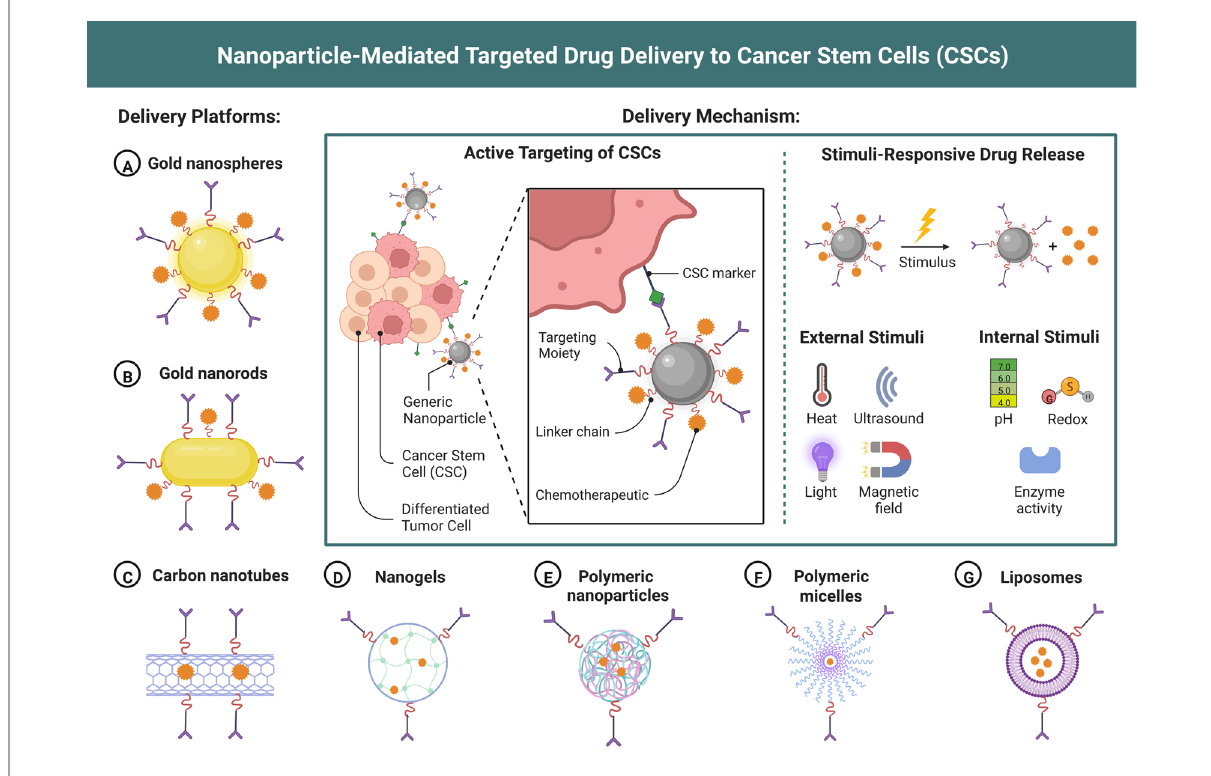
FIGURE 2 Nanoparticle-Mediated targeted drug delivery for cancer treatment. (Reprinted from “ Nanoparticle-Mediated Targeted Drug Delivery to Cancer Stem Cells ” , by BioRender, June